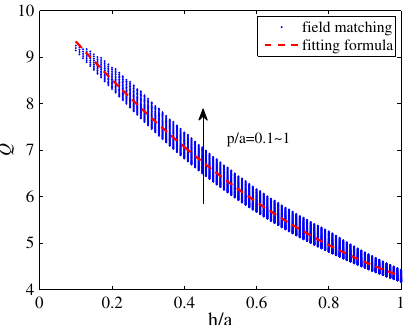
FIG. 14. Validity range (colored) of the fitting formula Eq. (18).